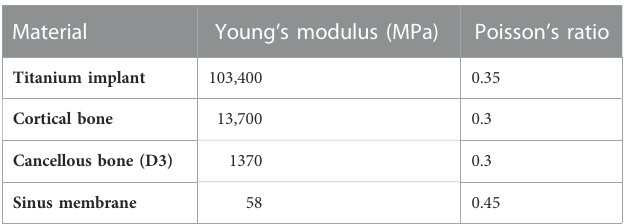
TABLE 1 Material